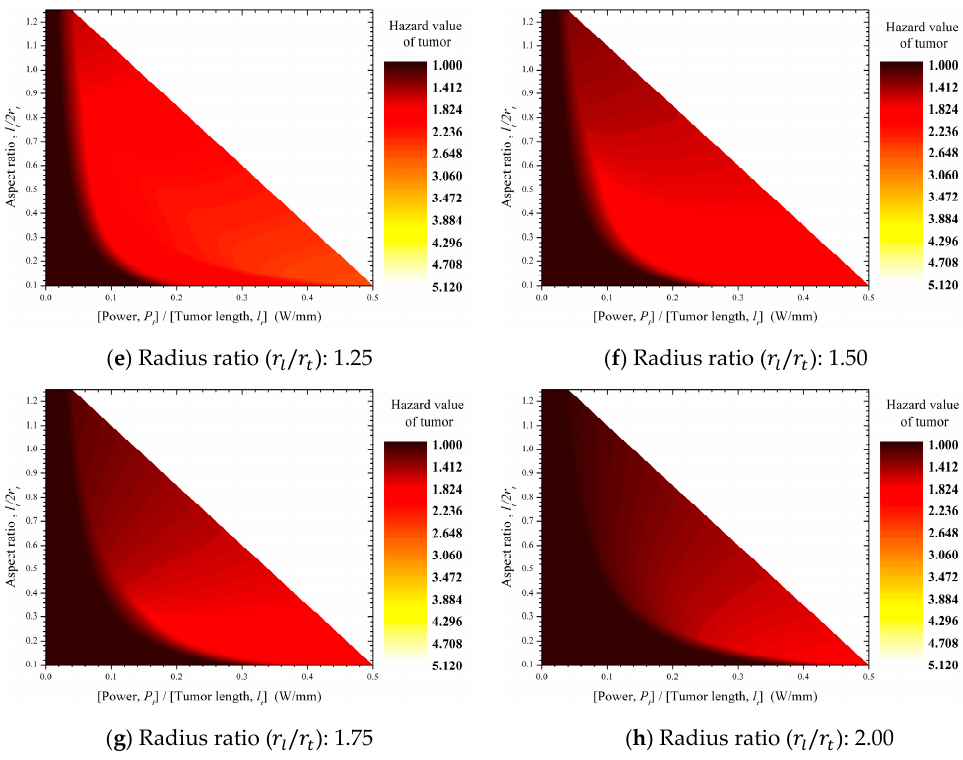
Figure 10. Contour graphs of the thermal hazard values of tumor tissues ( θ H , t